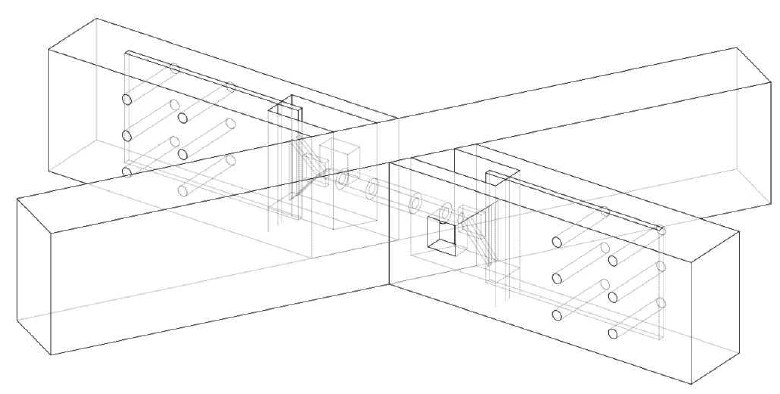
Figure 10. A complex joint with steel plates dowelled to the lamellae and connected to the central lamella with a threaded bolt.